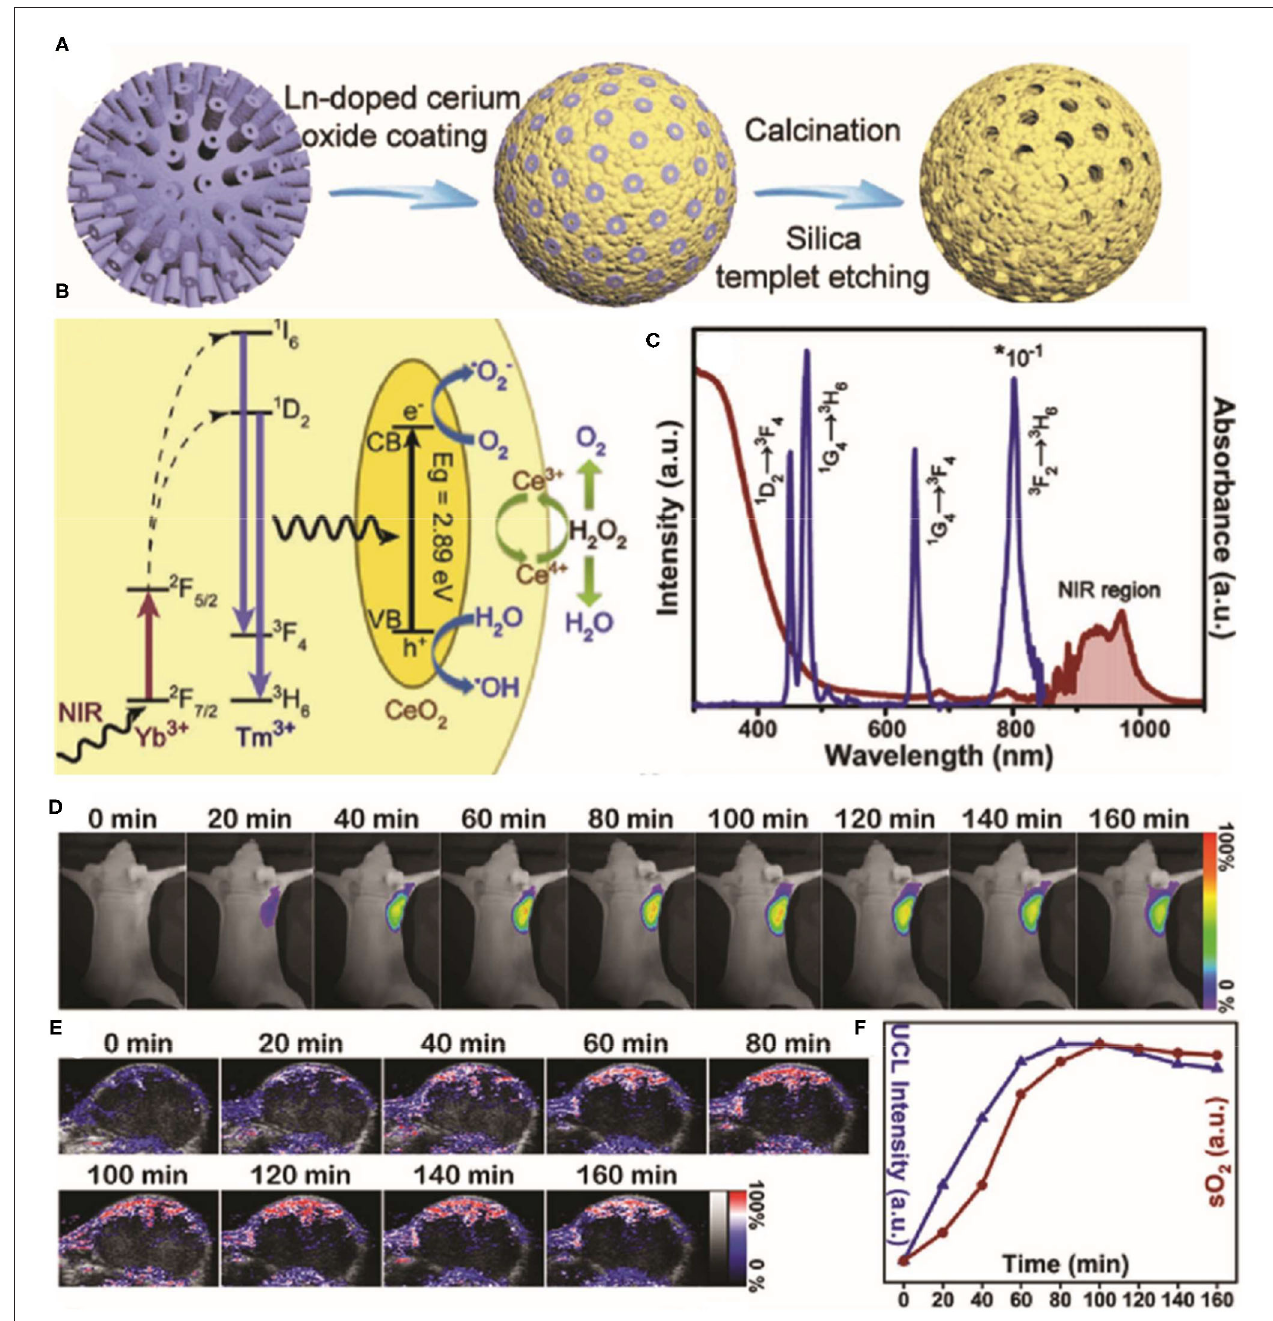
FIGURE 3 | Schematic illustration of the synthesis process (A) for the Yb 3 + /Tm 3 + codoped mesoporous cerium oxide hollow nanoparticles [cerium oxide upconversion nanoparticles (Ce-UCNPs)]. (B) Schematic illumination of the upconversion, photocatalysis, and enzyme-like catalysis mechanism of the Ce-UCNP (from left to right). (C) The UV–vis–IR Diffuse reflectance spectra (DRS) and Upconversion luminescence (UCL) of the Ce-UCNPs. (D) Upconversion bioimaging signals of Ce-UCNPs in the U87MG tumor regions. (E) Representative photoacoustic (PA) images of solid tumors by measuring oxygenated hemoglobin after injection of Ce-UCNPs at various time points. (F) Quantification of the upconversion bioimaging and the blood oxygen saturation signals in (D,E) . Reproduced with permission from Yao et al. (2018). Copyright (2018) Wiley-VCH. * p <